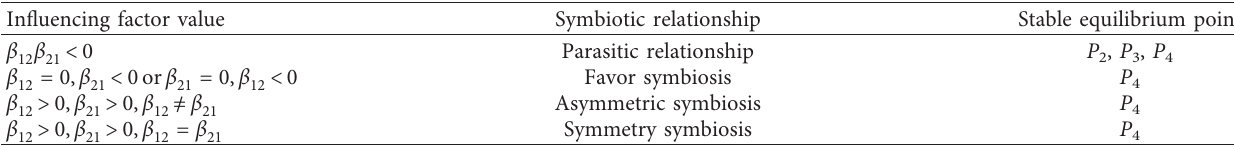
Table 2: Evolution mode among innovation